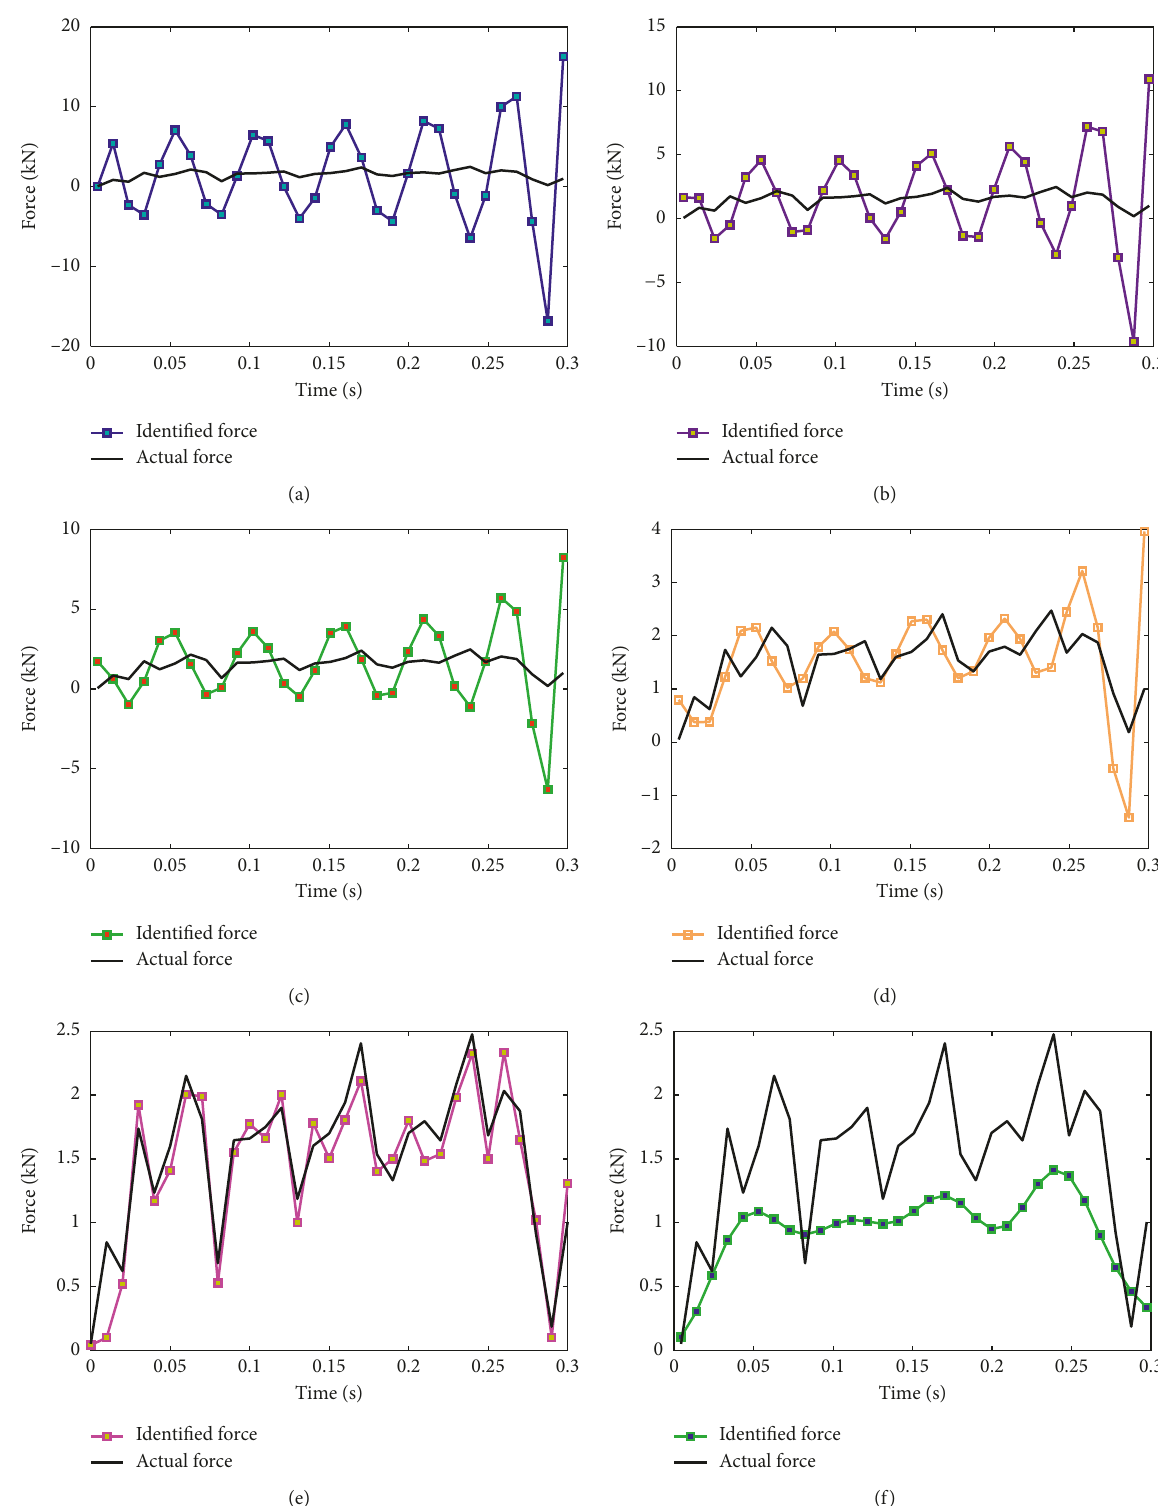
Figure 10: The identified results under different parameter ξ . (a) ξ � 10 0 ; (b) ξ � 10 − 1 ; (c) ξ � 10 − 5 ; (d) ξ � 10 − 10 ; (e) ξ � 10 − 15 ; (f) ξ � 10 − 20